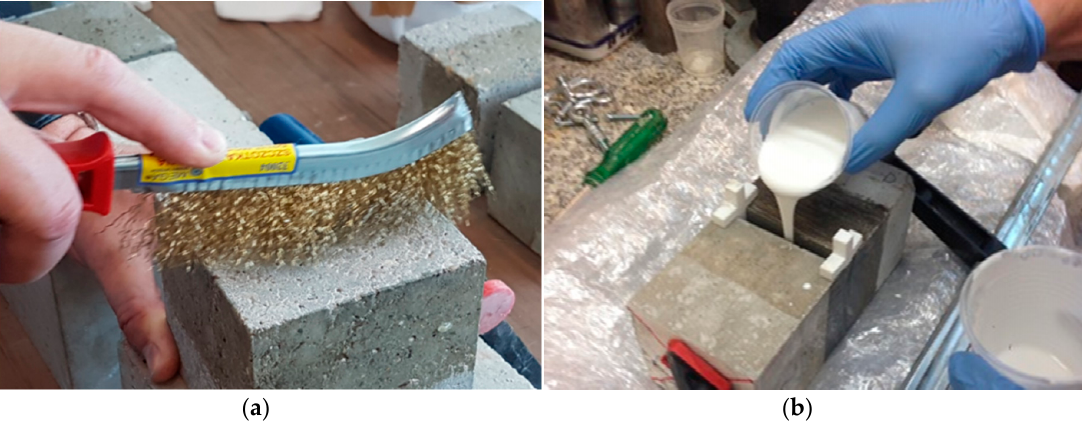
Figure 5. A view of the test stand: ( a ) testing machine, ( b ) close-up of a specimen during testing and ( c ) the adopted tension method.